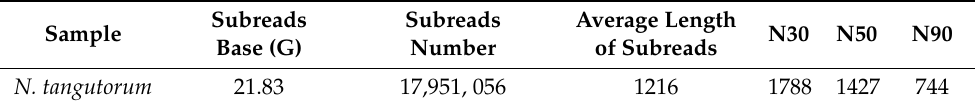
Table 1. Full ‐ length transcriptome sequencing data. Table 1. Full-length transcriptome sequencing data.